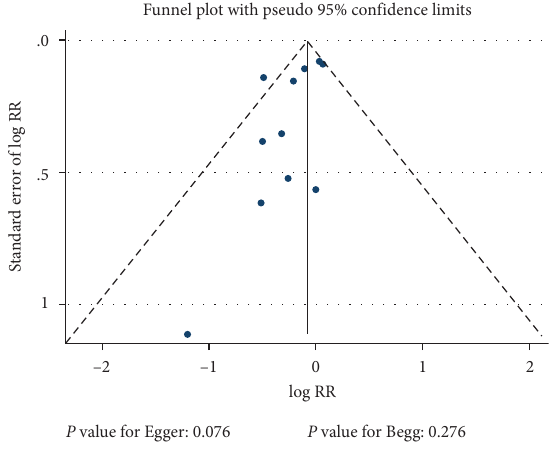
Figure 7: Funnel plot for mortality.